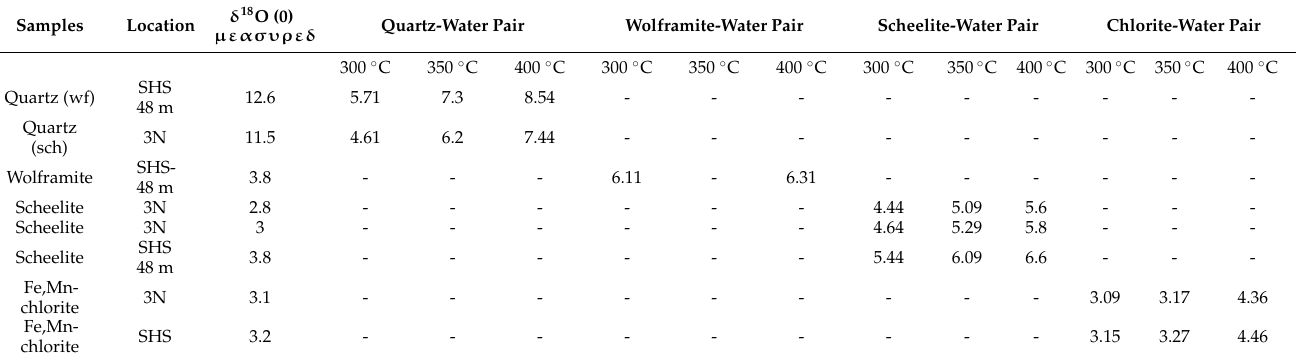
Table 5. Oxygen isotope data of quartz, wolframite, scheelite and Fe,Mn-chlorite minerals. δ 18 O (0) Samples Location µεασυρεδ Quartz-Water Pair